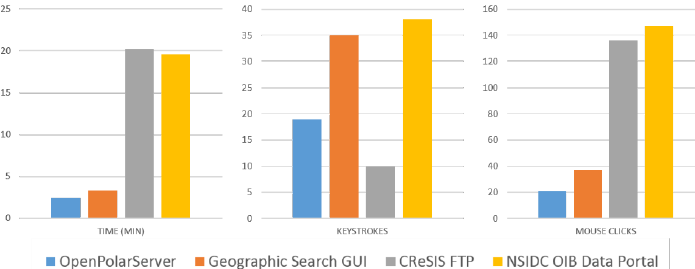
Figure 9. Results from the comparison of four data distribution systems (OPS, old Geographic Search GUI at CReSIS, CReSIS FTP, and NSIDC OIB Data Portal). The processing time, number of keystrokes, and number of mouse clicks required to download the same dataset are shown for each system.